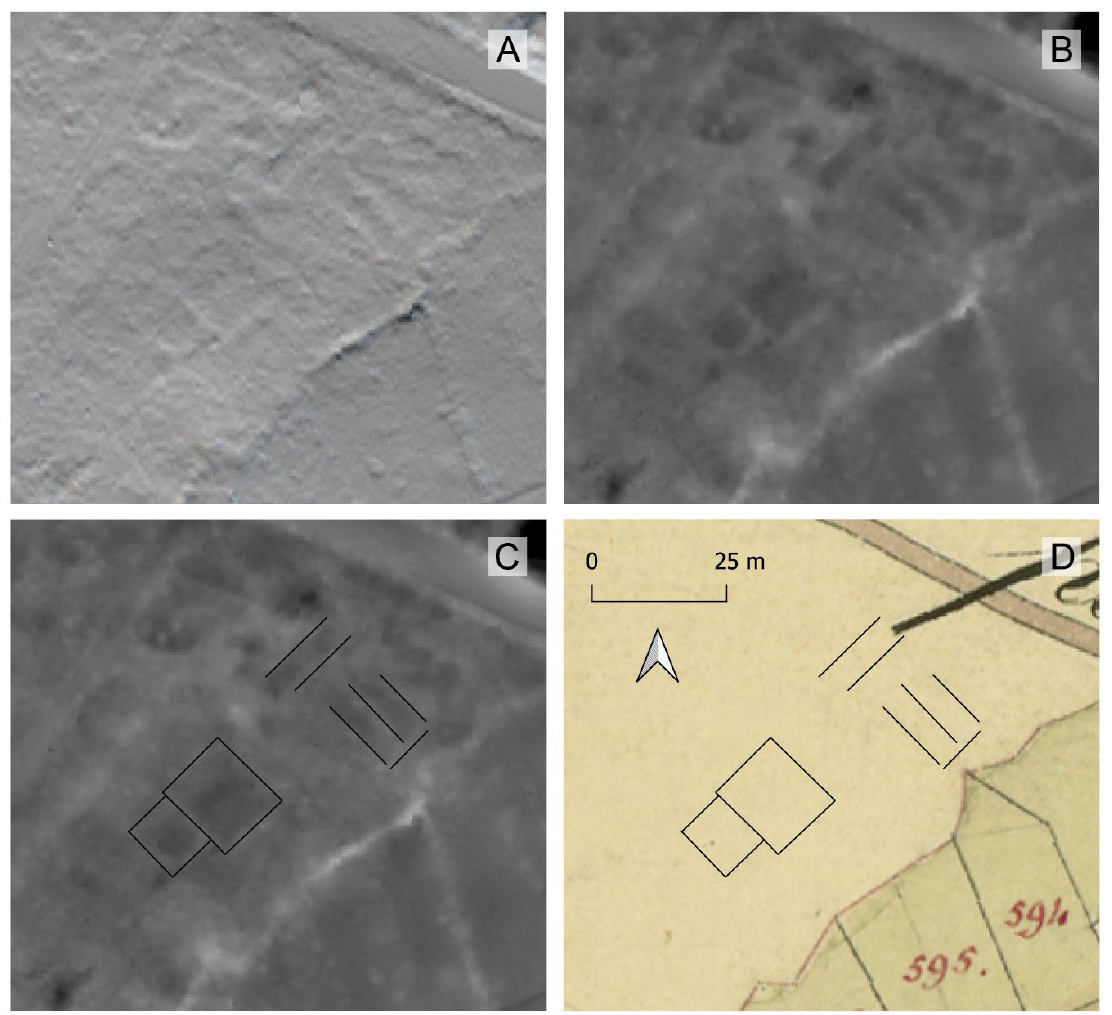
Figure 21. Zoomed view of possible archaeological features in area M of Figure 2: hill-shaded image ( A ), local relief model ( B ), interpreted local relief model ( C ) and digitized features superimposed onto a 19th century cadastral map ( D ).